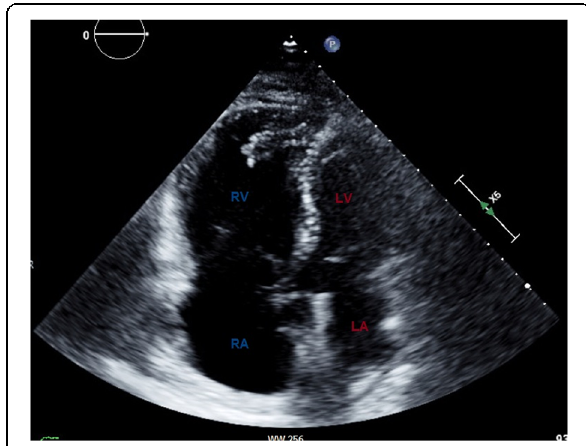
Fig. 17 Four-chamber view on echocardiogram in a patient with CTEPH. Echo demonstrates RV and RA dilatation compared to the LV and LA (labeled)